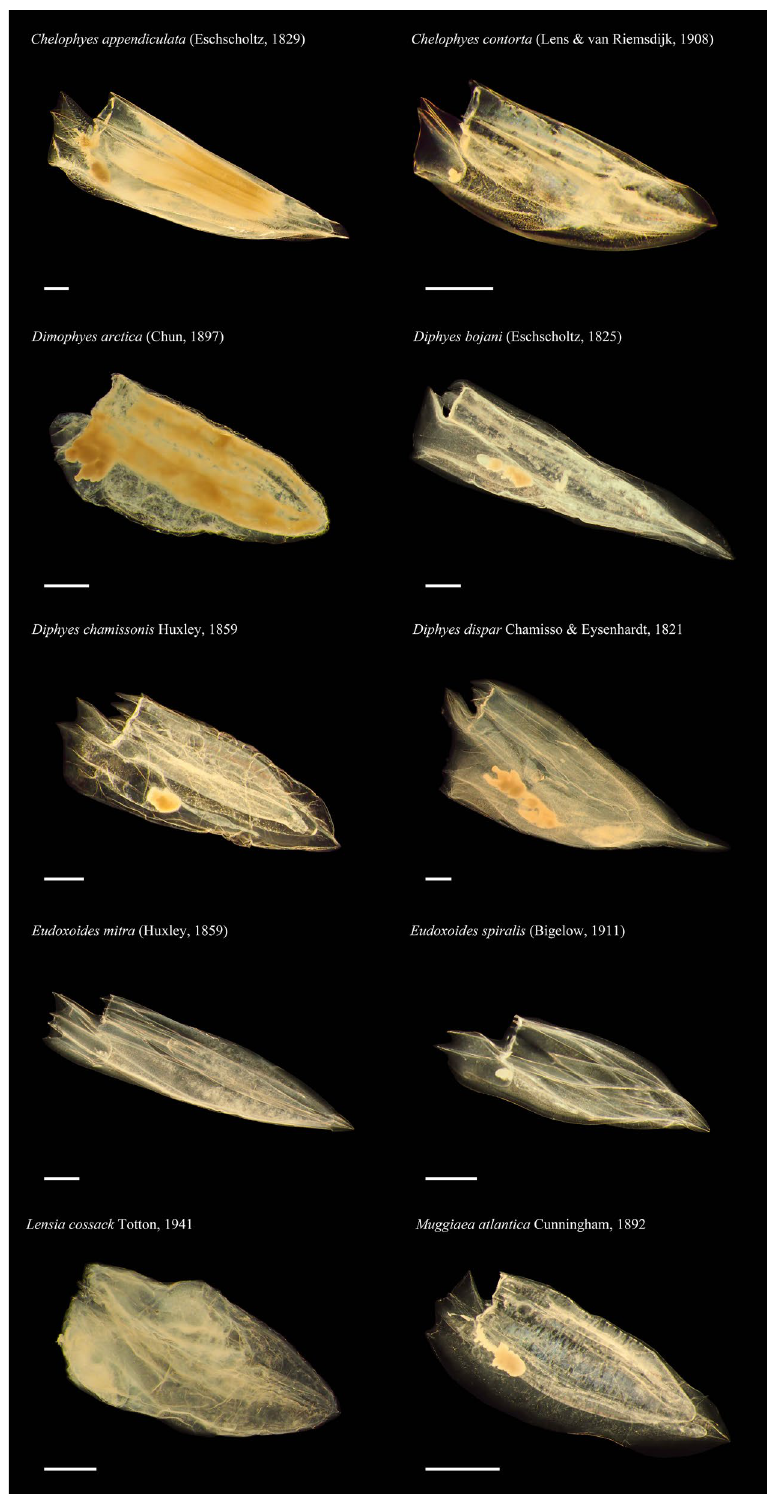
Figure 2. Digital images of anterior nectophores from target Diphyids. All specimens are ethanol fixed. Scale bar = 1